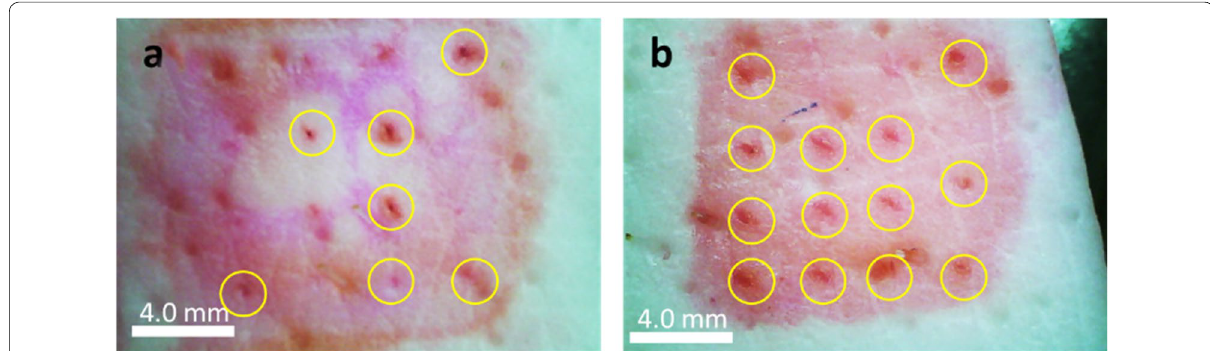
Fig. 5 Images of the cadaver porcine after inserted with PVP‑MAA microneedle patch. The weight ratio of PVP and MAA was varied at 100:10 ( a ) and 100:20 ( b ). The successful insertions are marked with yellow circles